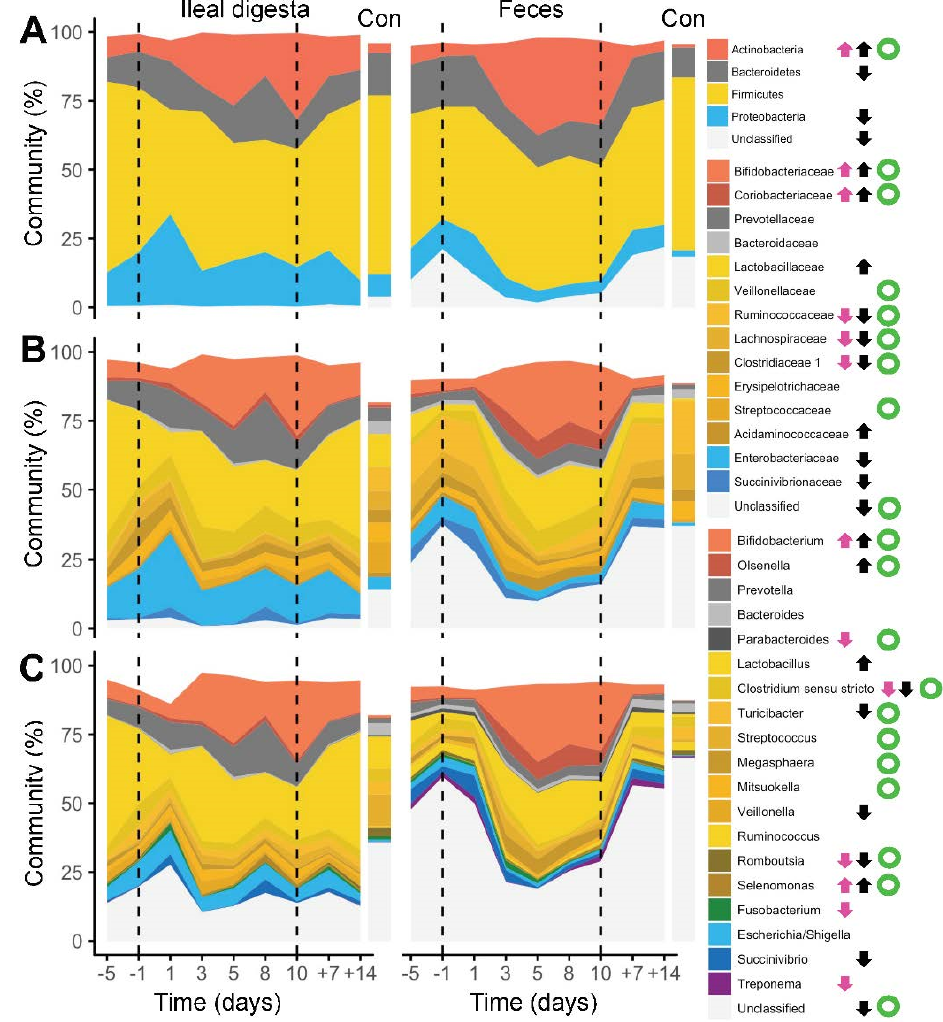
Figure 3. Alterations of individual bacterial phyla ( A ), families ( B ) and genera ( C ) in ileal digesta and fecal samples during the experiment (dashed lines highlight period of enzyme withdrawal). Data from Control pigs (Con) is also provided. Arrows indicate significant changes in relative abundance of taxa before and after PERT depletion (pink: ileal digesta, black: feces), whereas green open circles show significant correlations (FDR corrected Spearman’s rho < 0.05) between the two sites.